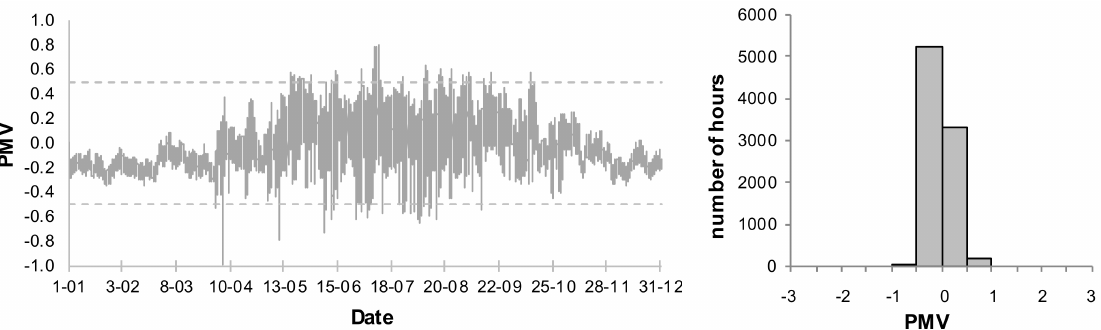
Figure 9. Annual variation and frequency distribution of PMV for living room in case 1.